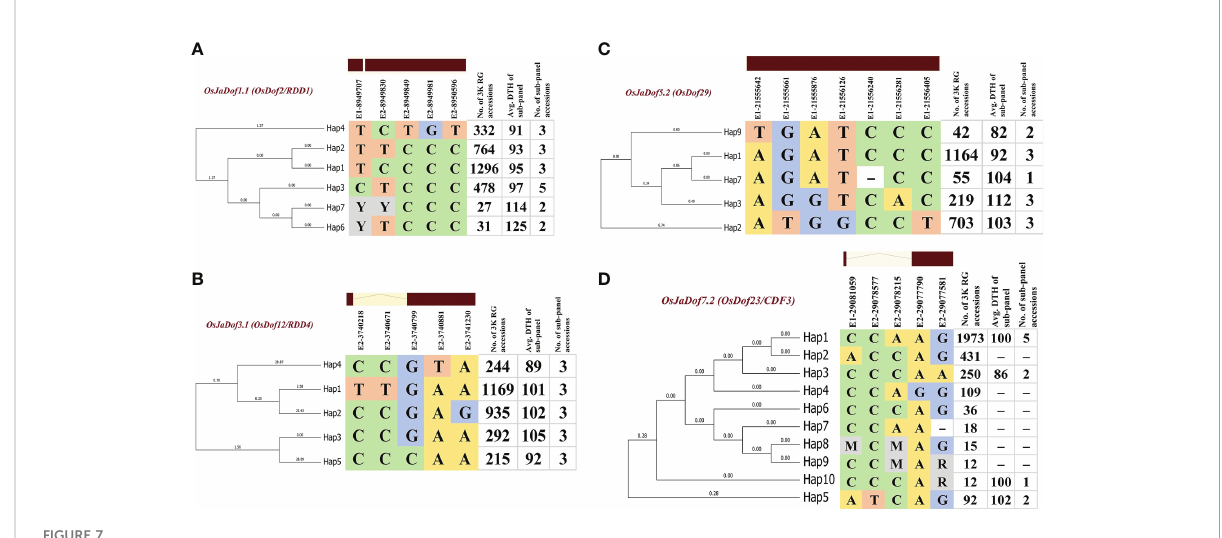
FIGURE 7 Superior haplotypes of four orthologous genes across genus Oryza including (A) OsJaDof1.1 , (B) OsJaDof3.1 (C) OsJaDof5.2 , and (D) OsJaDof7.2 signi fi cantly associated with days to heading data from fi eld evaluation. The genomic positions of non-synonymous substitutions in the coding region of genes are indicated above the haplotype blocks with E1 and E2 indicating exon 1 and exon 2, respectively followed by the genomic position of SNP-based